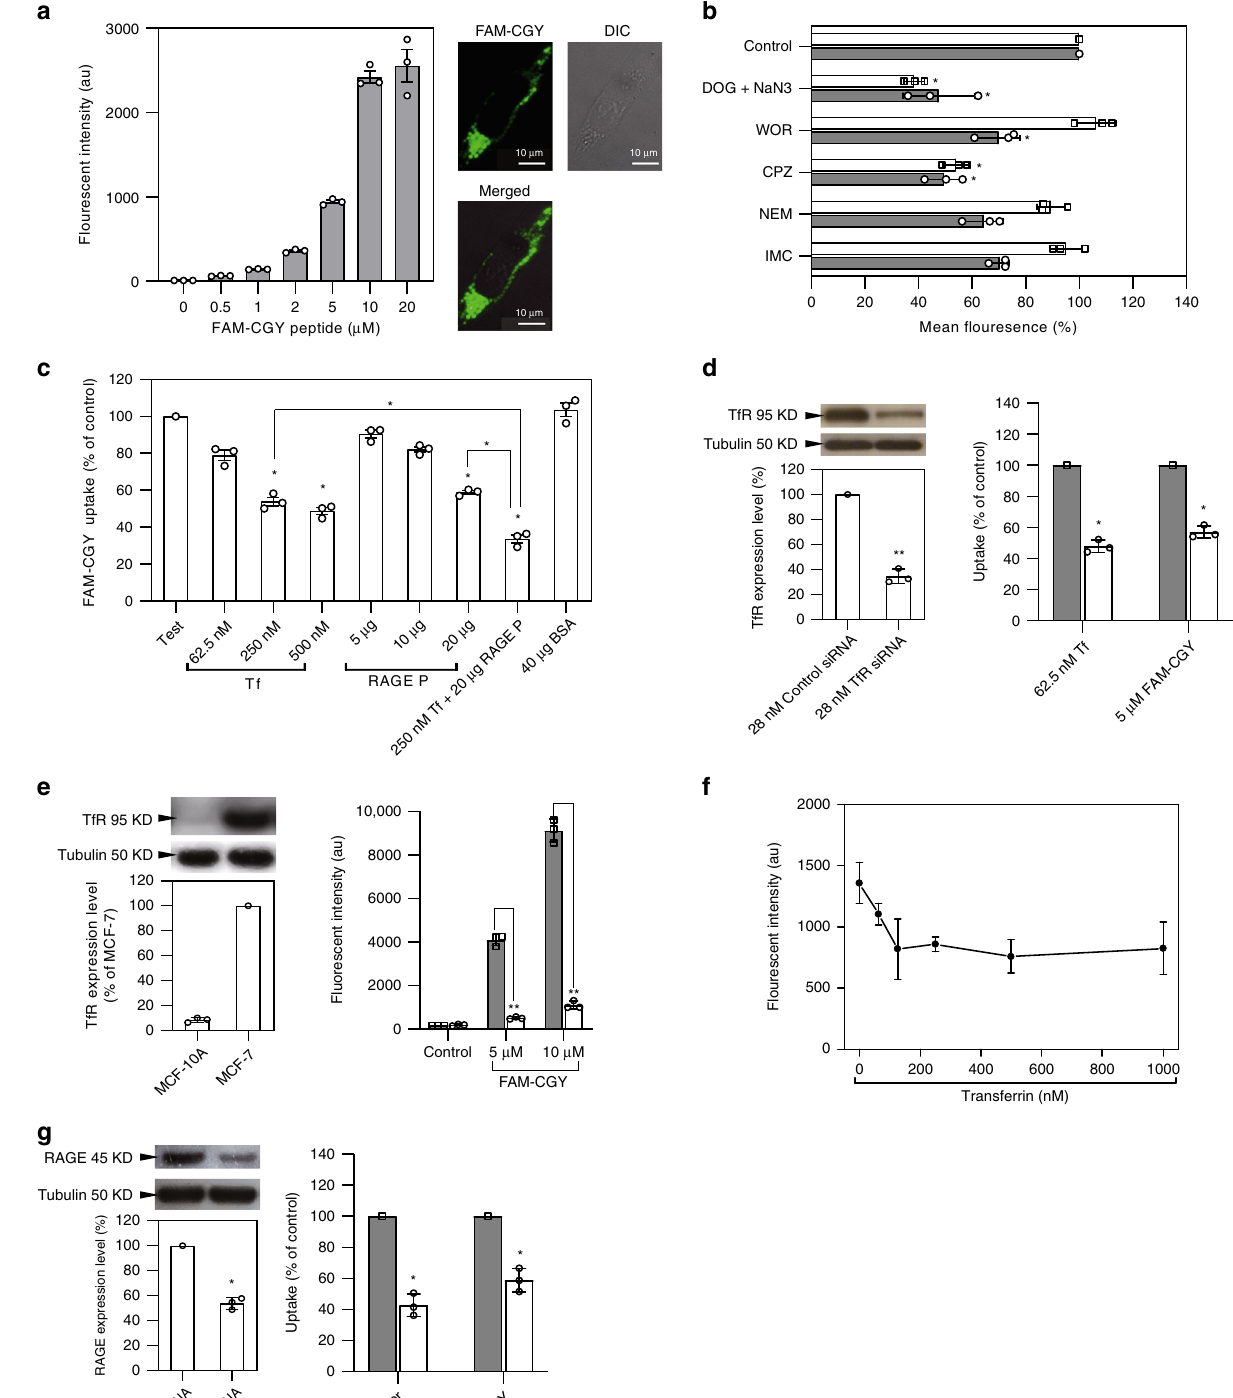
structures in NLC nano fi bres and the proto fi lament components of the “ core-shell ” nanoparticles and direct internalisation. We tested this hypothesis by showing a signi fi cantly less ( p < 0.05; non-paired two-sided student t -test) NLC uptake by hCMEC/D3 cells in competition with increasing concentration of a commer- cially available RAGE ligand (Fig. 2b). Also, lowering RAGE expression in hCMEC/D3 cells with a RAGE-speci fi c siRNA (the NATURE COMMUNICATIONS| (2019) 10:4635